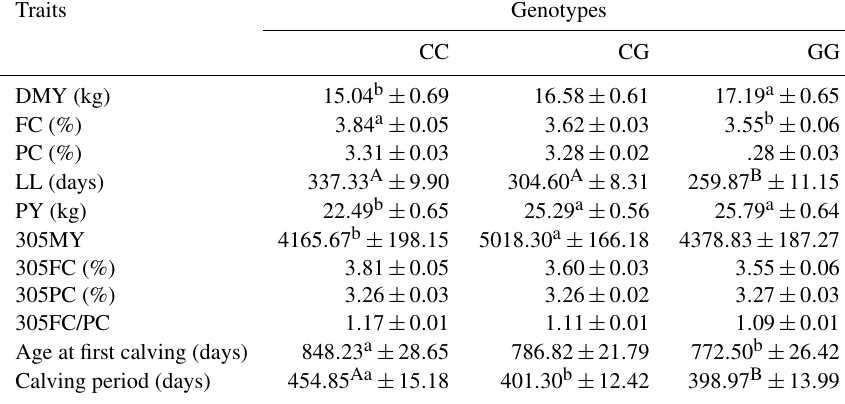
Table 3. Means and standard error of productive and reproductive traits in Agerolese cows with different genotypes at g.-274C > G.